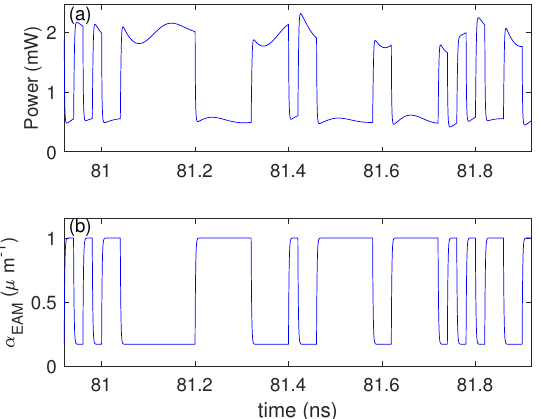
Figure 7. (color online) Time traces for digital, non-return-to-zero modulation of EAM VCSEL at 100 Gb/s. ( a ) Output power; ( b ) α EAM .